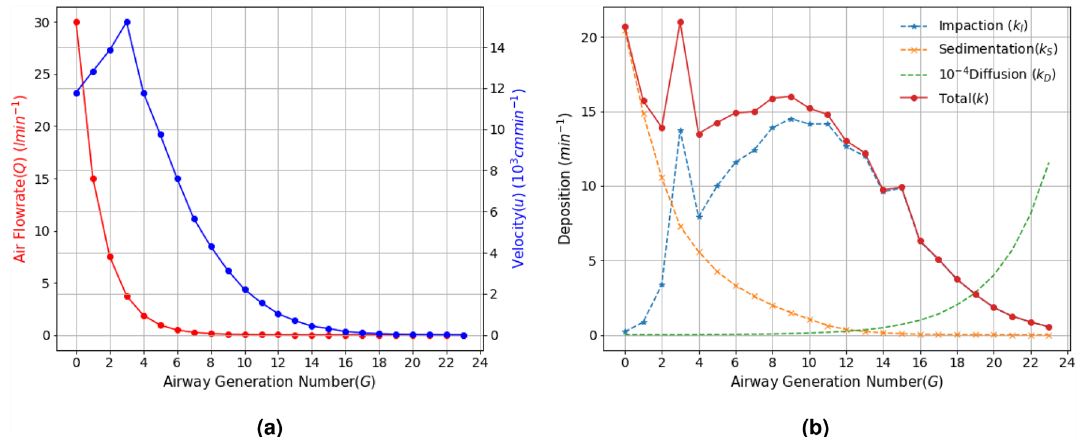
Figure 2. Airflow rate, velocity and virus deposition. The change in airflow rate Q and velocity u ( a ) along with deposition k ( b ) over the airway generations in the respiratory system when the inlet airflow rate Q 0